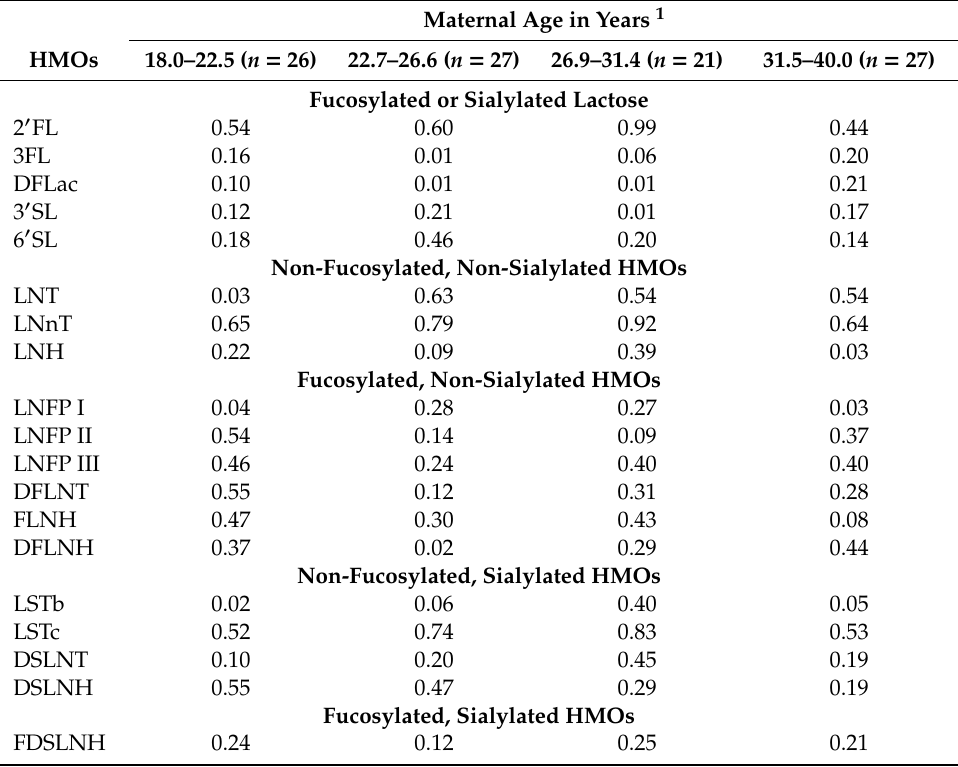
Table 6. NMF scores according to maternal age quartiles for individual